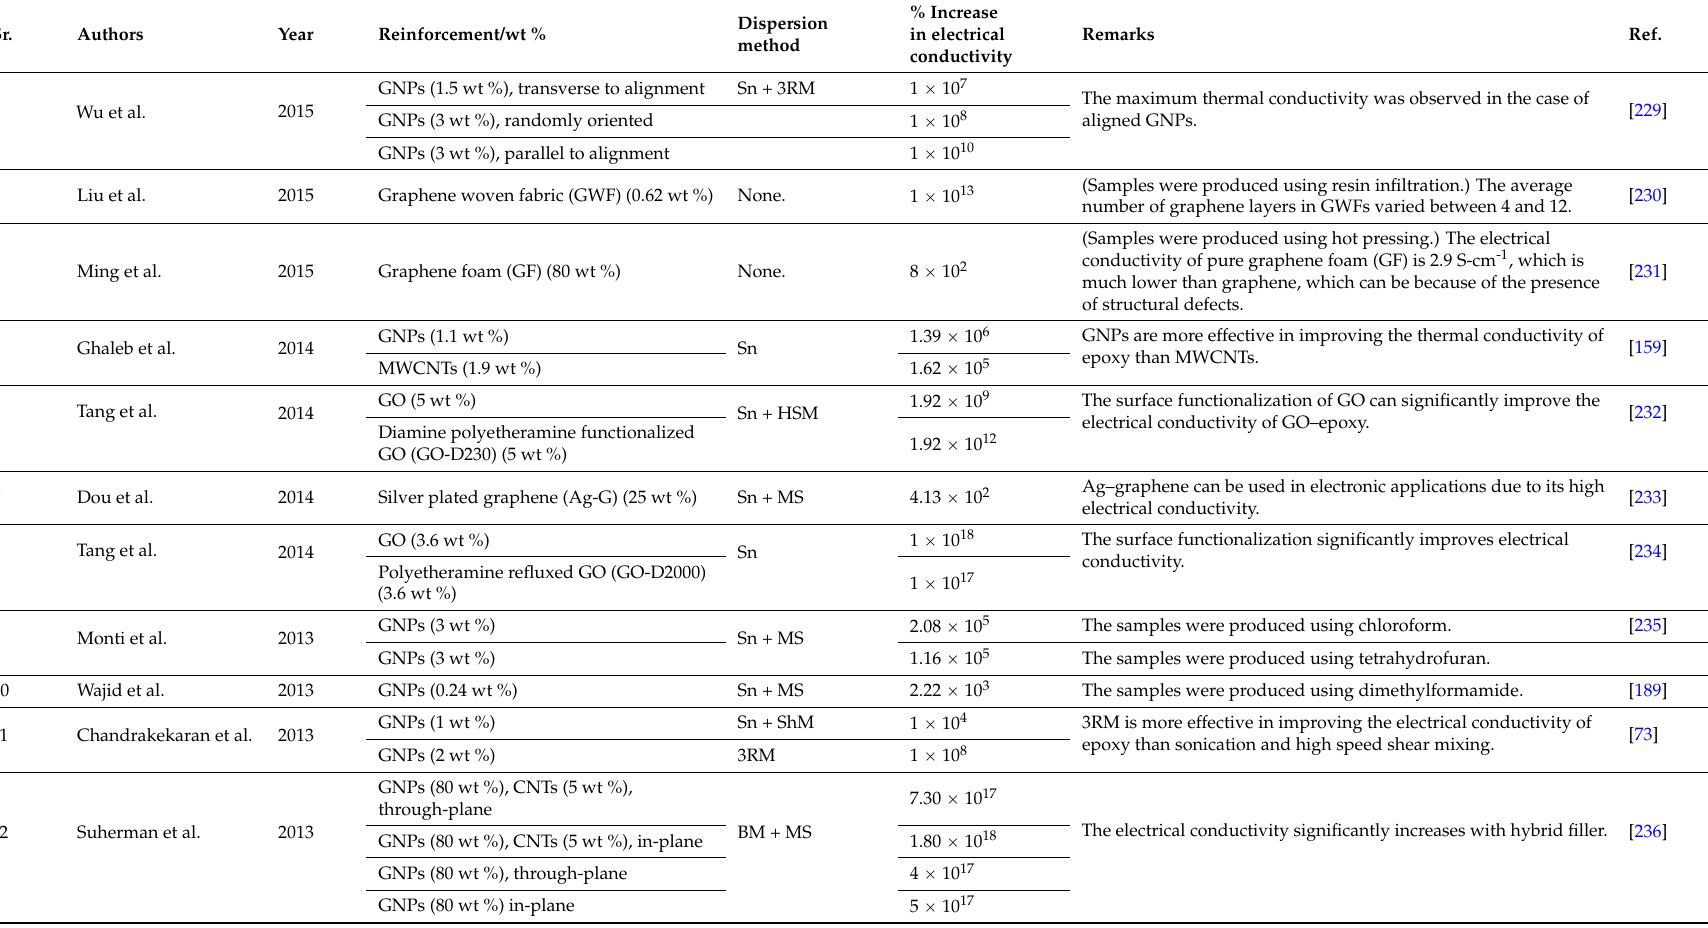
Table 3. A brief record of epoxy-based nanocomposites studied for improvement in electrical conductivity values. HSM: high speed